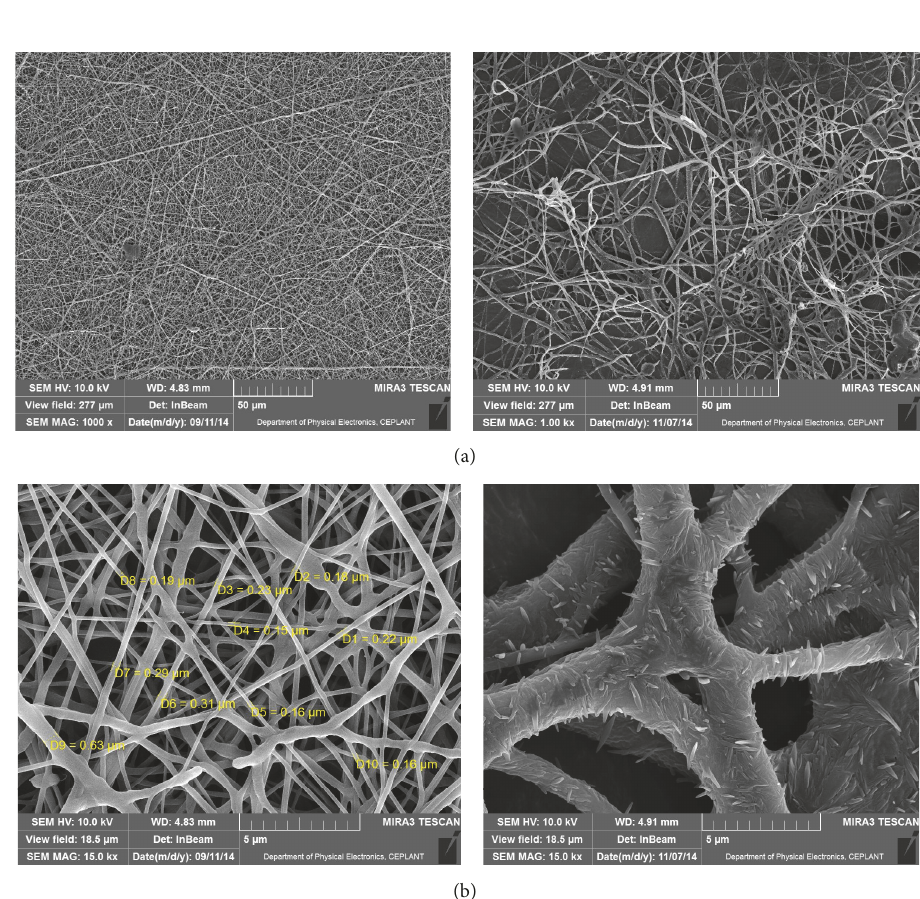
Figure 2: SEM images of PA6 (left) and NBIPA (right) electrospun nanofibers in different magnifications.